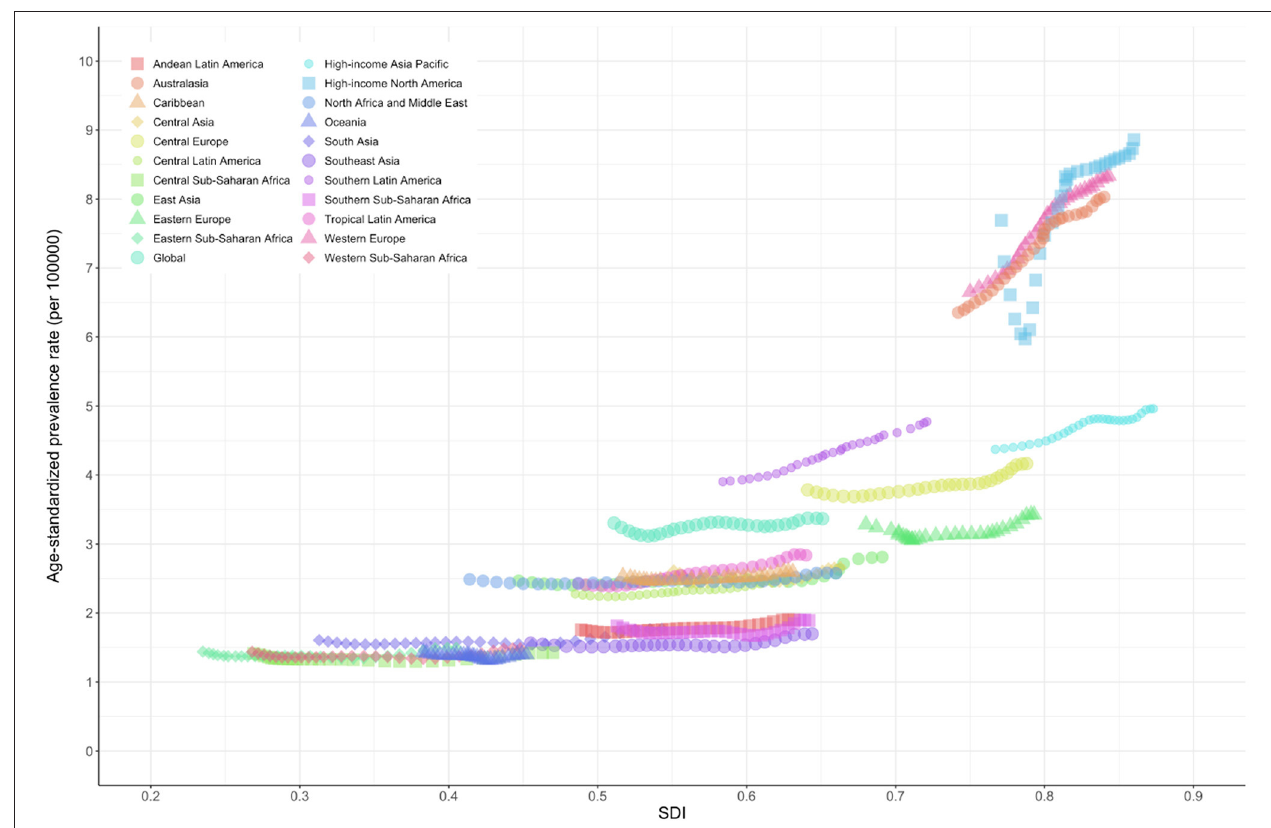
FIGURE 3 | Age-standardized prevalence rates of motor neuron diseases by Global Burden of Disease regions by sociodemographic index, 1990–2019. Age-standardized prevalence rates are presented as number affected by motor neuron diseases per 100,000 population. SDI, sociodemographic